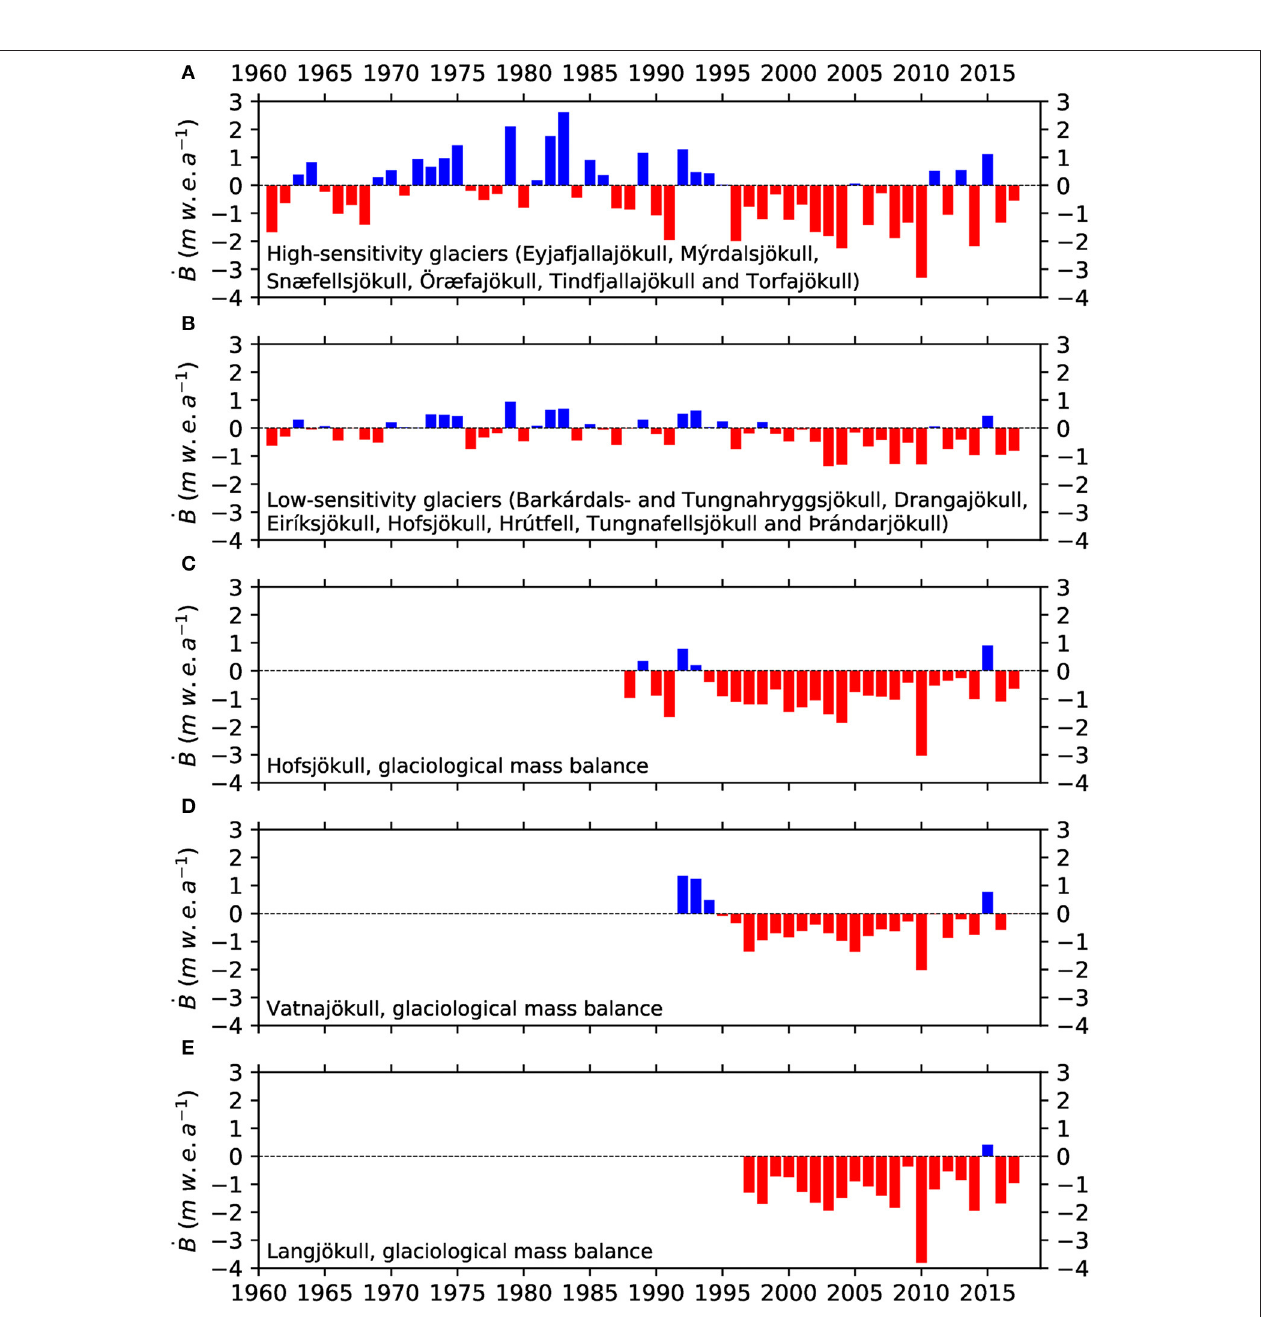
FIGURE 7 | (A,B) Area-weighted average annual mass balance of the two sub-regions, obtained from Equation (1) over the period 1960–2017. (C–E) Glaciological mass balance measured on Hofsjökull, Vatnajökull, and Langjökull (Thorsteinsson et al., 2017; WGMS, 2019; Aðalgeirsdóttir et al., submitted).